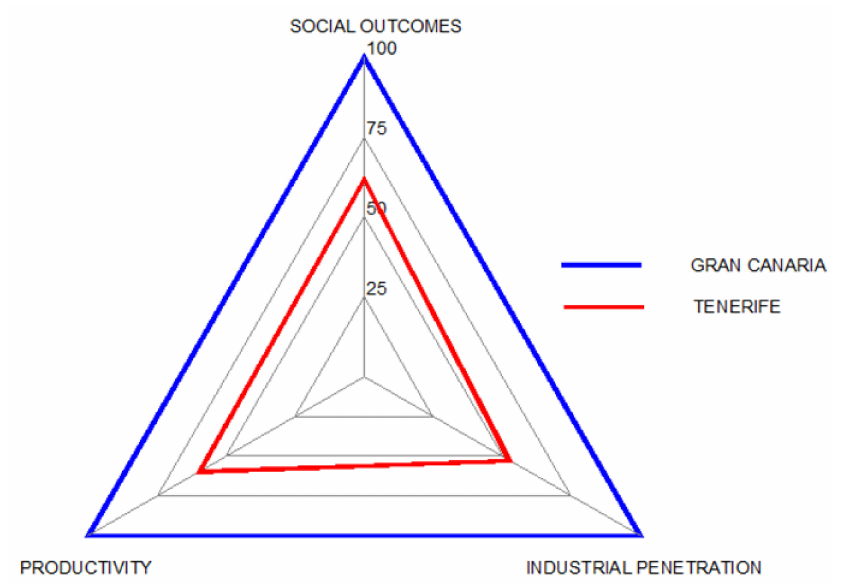
Figure 7. Comparative outcomes for Gran Canaria and Tenerife.